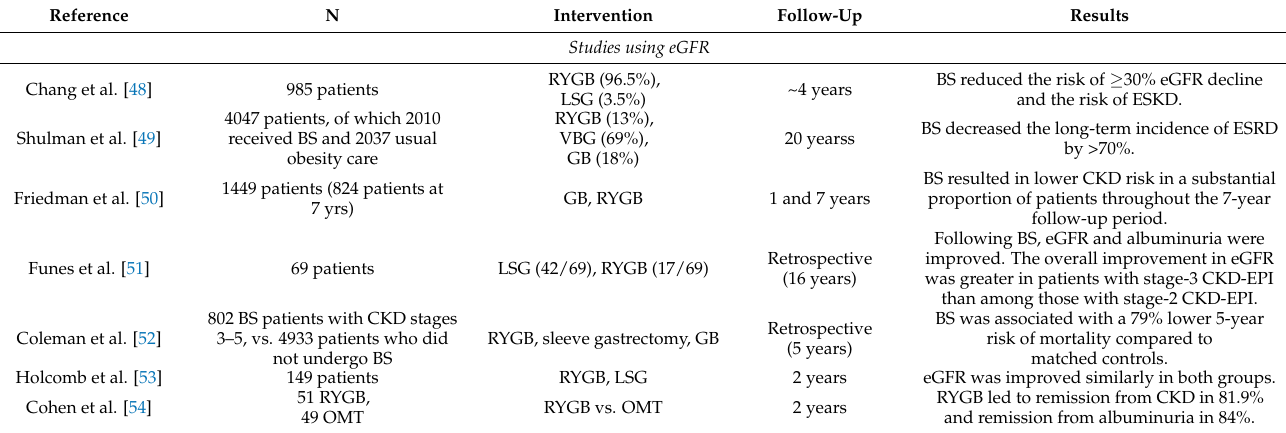
Table 1. Summary of the effects of surgery-induced weight loss on GFR and